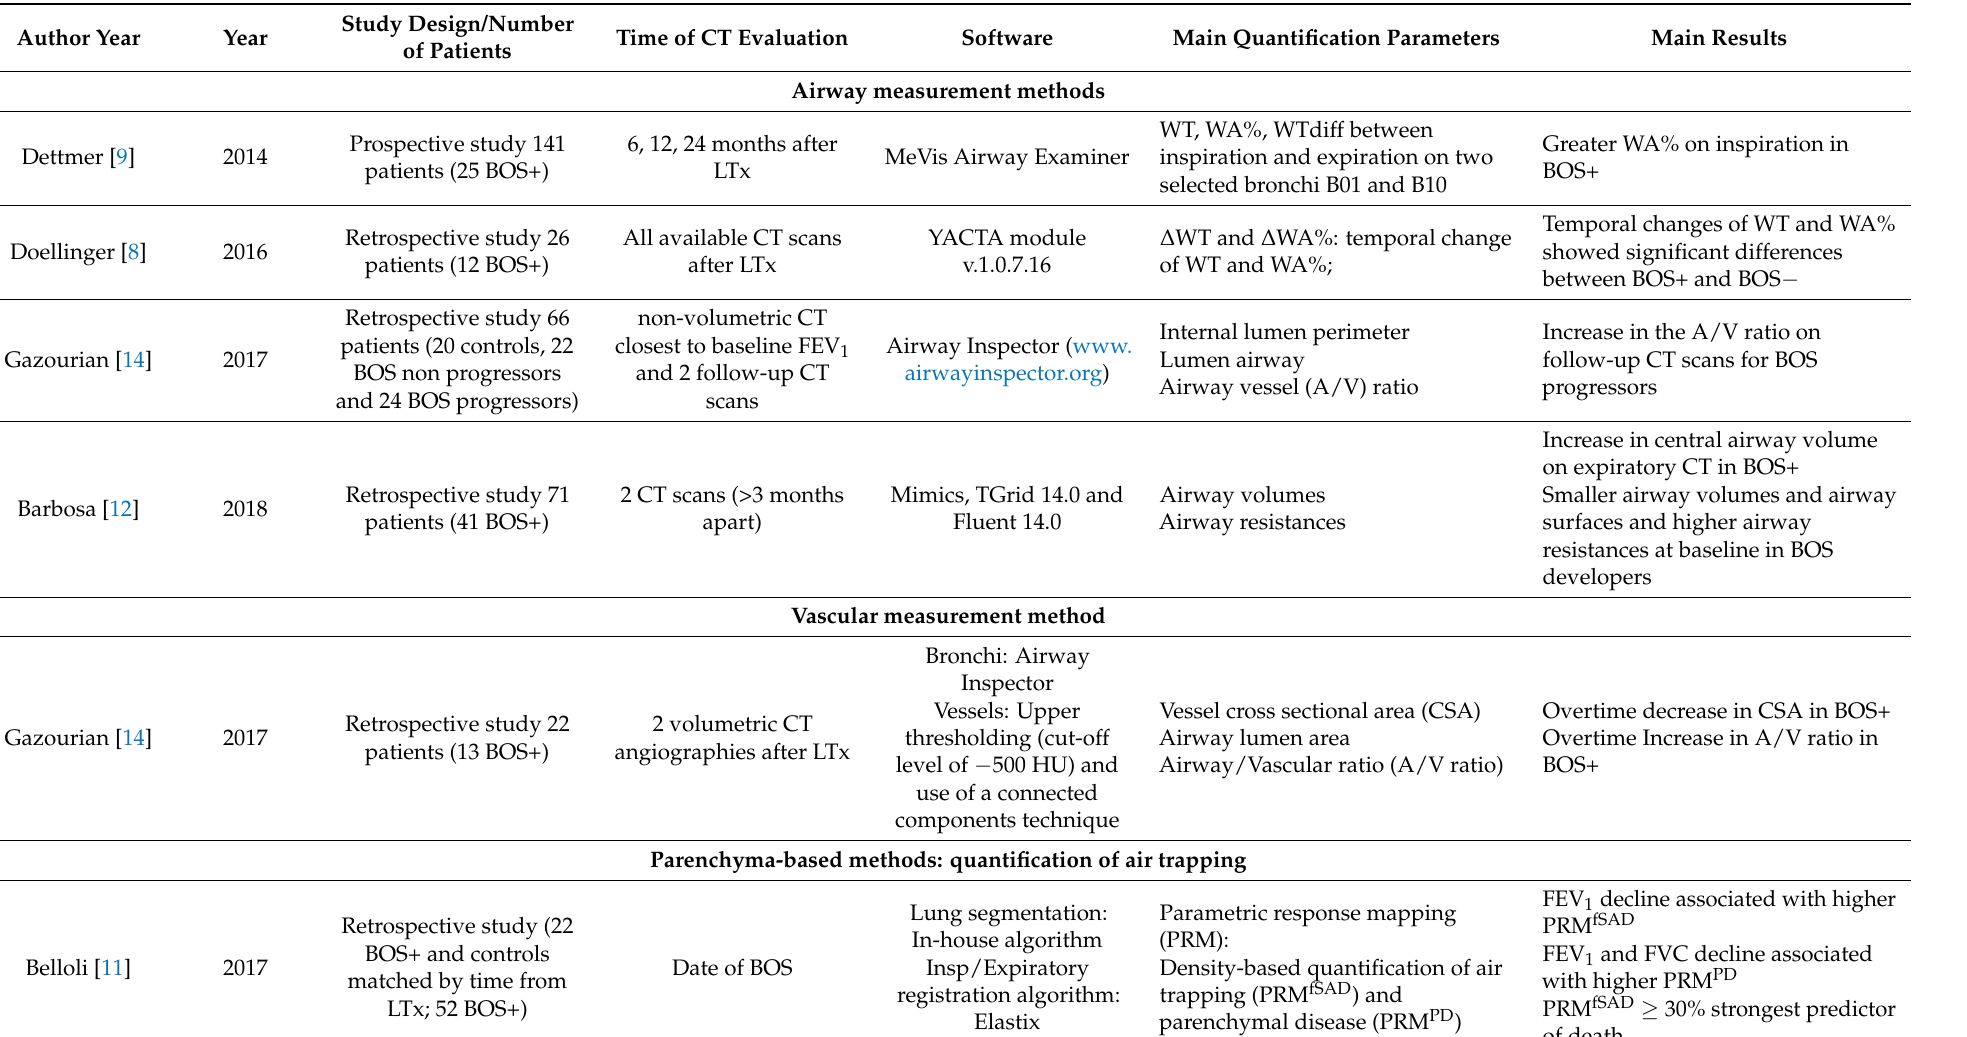
Table 2. Overview of CT quantification methods for